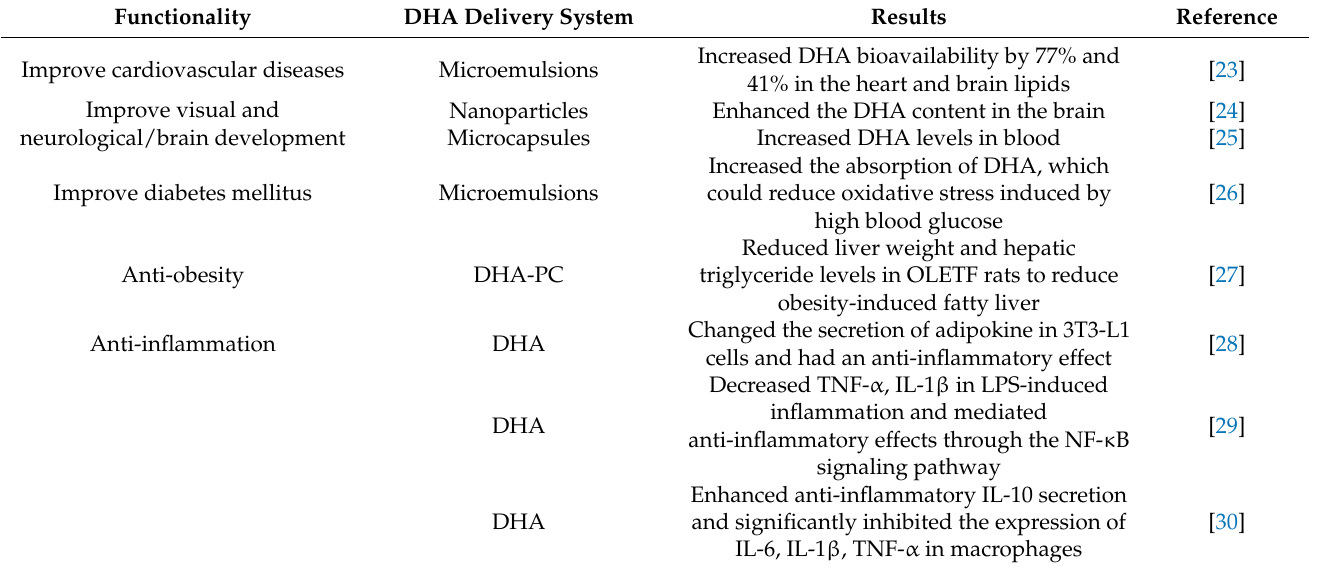
Table 2. Functionality of DHA in delivery